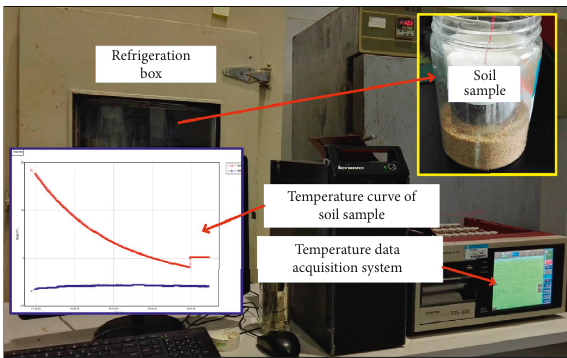
Figure 4: Test of freezing temperature of soil samples.